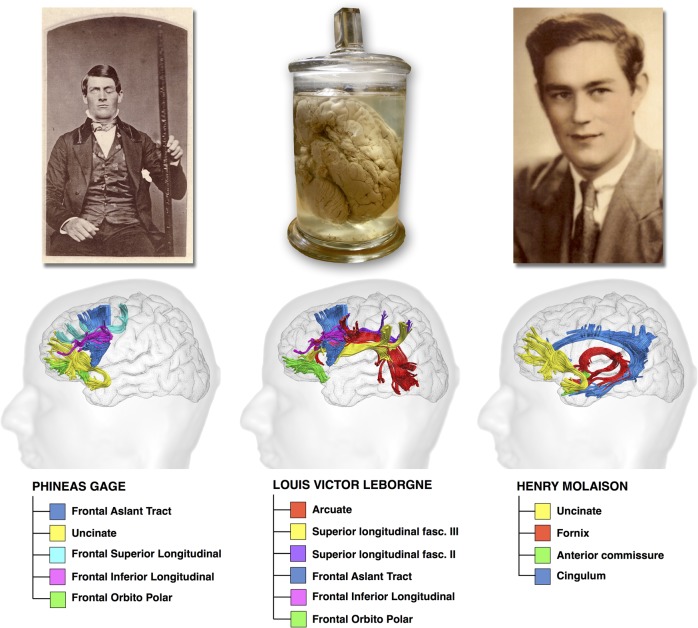
Major tracts that were damaged in Gage (damage affected at least 30% of the tracts' volume, z-score = 1.7), in Leborgne (damage affected at least 55% of the tracts' volume, z-score = 1.29), and in Molaison (damage affected at least 5% of the tracts' volume, z-score = 1.39).